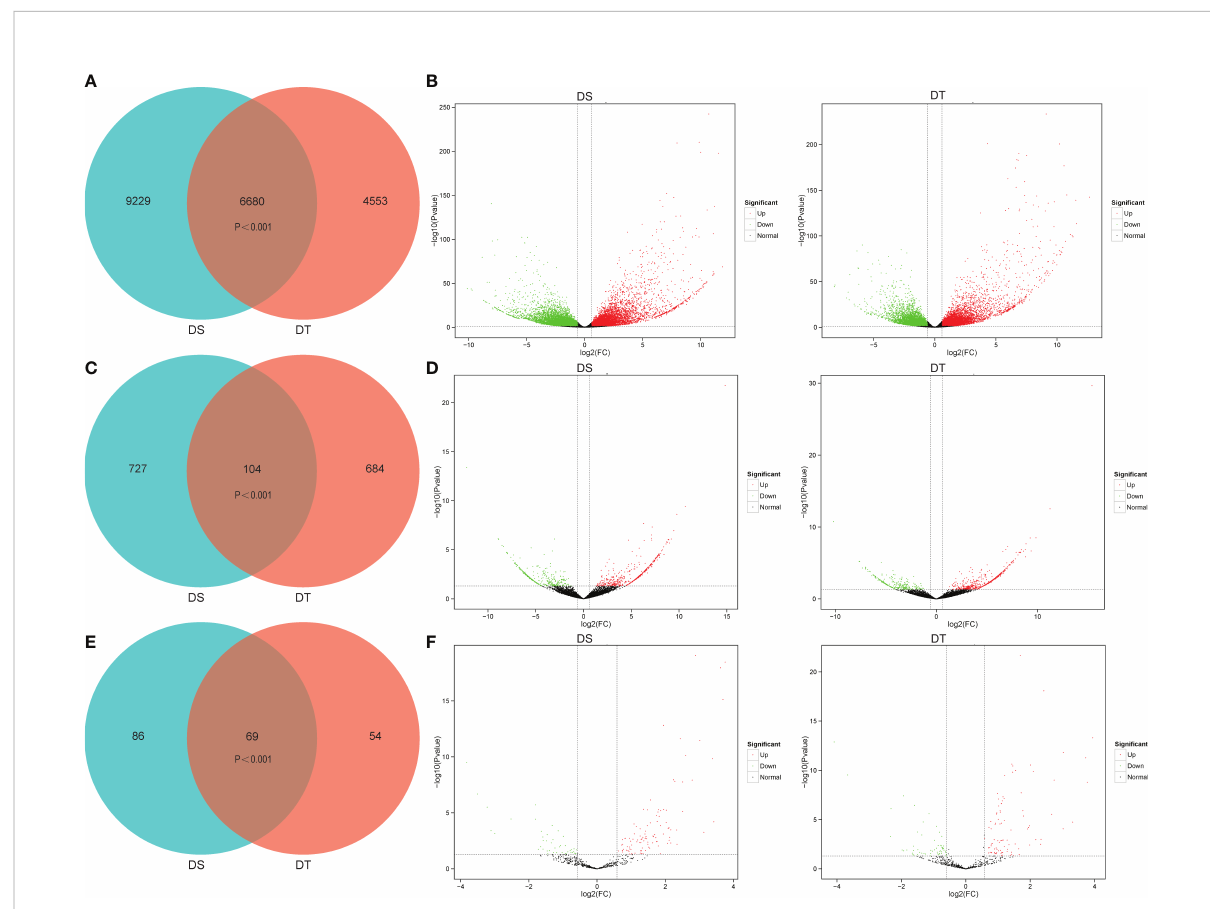
FIGURE 2 Differentially expressed genes (DEGs), differentially expressed lncRNAs (DELs), and differentially expressed miRNAs (DEMs) at the seedling stage of the two wheat varieties under drought stress relative to control conditions. DS, drought-sensitive variety JM38, DT, drought-tolerant variety ZM13. (A, B) Venn diagram and volcano plots of DEGs of JM38 (DS) and ZM13 (DT). (C, D) Venn diagram and volcano plots of DELs of JM38 (DS) and ZM13 (DT). (E, F) Venn diagram and volcano plots of DEMs of JM38 (DS) and ZM13